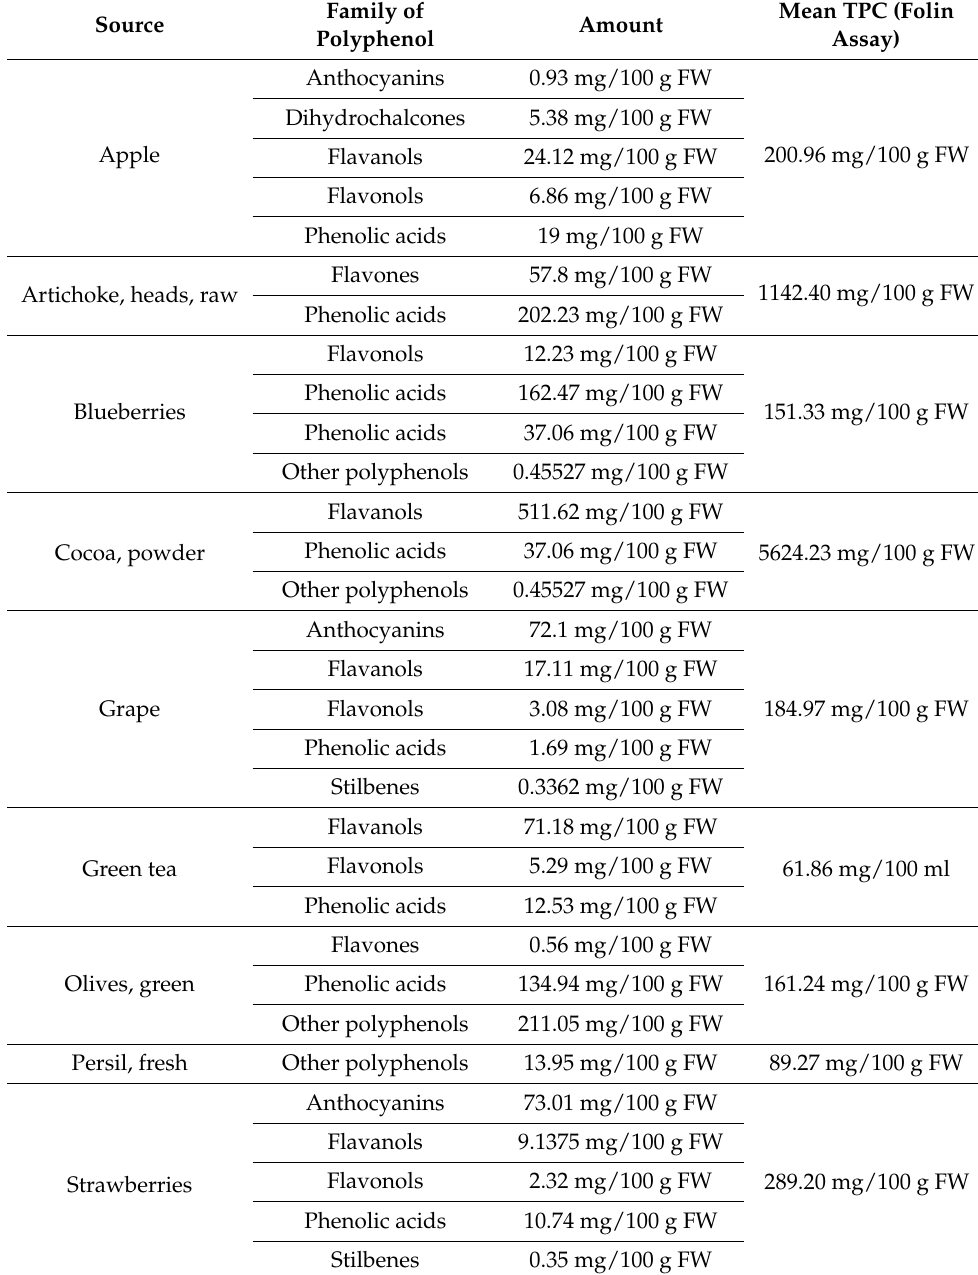
Table 1. Polyphenols characterization, total polyphenol content (TPC) of major well-known vegetal sources of dietary polyphenols. TPC is expressed in mg/100 g of fresh weight (FW). Data in the table were extracted from the PhenolExplorer database